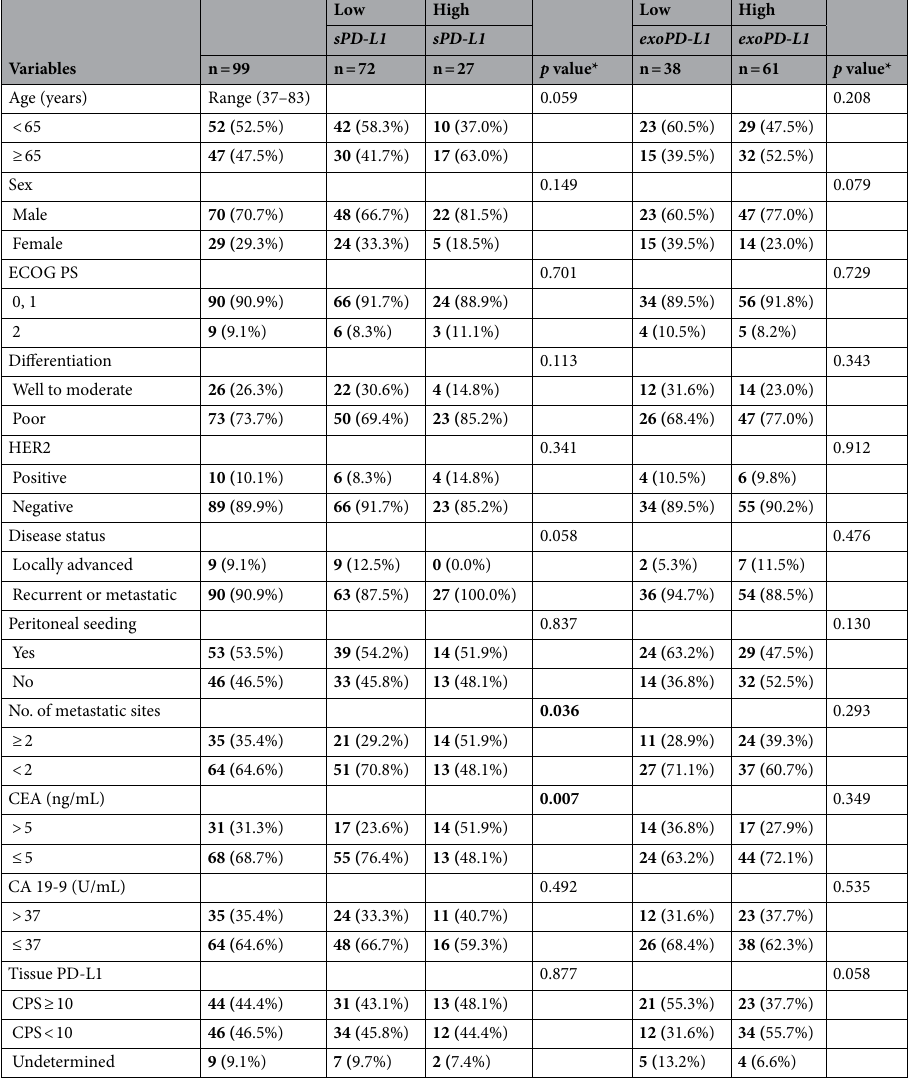
Fig. S2 online). However, sPD-L1 was not correlated with any inflammation markers above. The correlation with tumor markers was also investigated. Both CEA and CA 19-9 showed a weak positive correlation with sPD-L1 level (sPD-L1 and CEA; Spearman’s ρ = 0.232, p = 0.022, sPD-L1 and CA 19-9; Spear- man’s ρ = 0.238, p = 0.019) (Fig. 3), but exoPD-L1 was not correlated with both tumor markers. Correlation with immunomodulatory cytokines. The correlation of both sPD-L1 and exoPD-L1 with immunomodulatory cytokines was explored. exoPD-L1 was positively correlated with TGF-β1 (Spearman’s ρ = 0.357, p < 0.001) and IFN- γ (Spearman’s ρ = 0.332, p < 0.001). The high exoPD-L1 group had higher levels of TGF-β1 and IFN- γ than the low exoPD-L1 group (TGF-β1; p = 0.047, IFN- γ ; p = 0.006) (Fig. 4). However, sPD- L1 was not associated with the cytokines investigated. Correlation with T lymphocytes. The correlation between extracellular PD-L1 and peripheral T lympho- cyte was analyzed. exoPD-L1 level was negatively correlated with the frequency of CD8 + T cells in peripheral blood (Spearman’s ρ = − 0.215, p = 0.039). The high exoPD-L1 group showed a significantly lower frequency of CD8 + T cells than the low exoPD-L1 group ( p = 0.021). The high exoPD-L1 group showed a higher frequency of